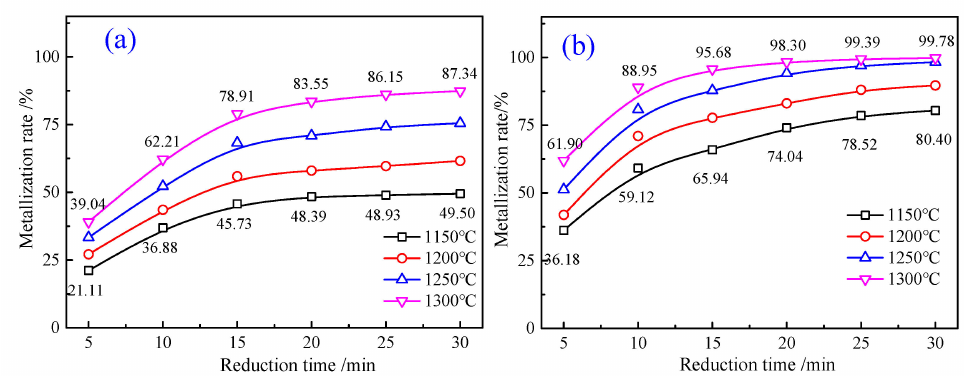
Figure 4. Effect of reduction time and temperature on metallization rate at a FC/O of 1.1 in reduction roasting process of ( a ) Fe-Al ores and ( b ) 70%Fe-Mn ore + 30% Fe-Mn